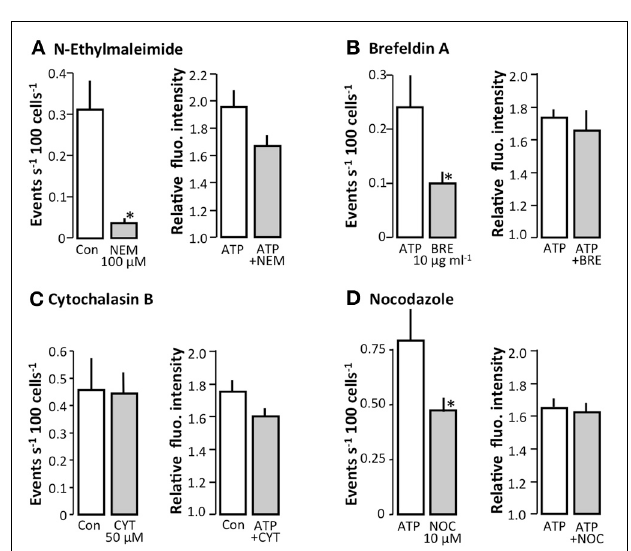
FIGURE 3 | The effect of various inhibitors of the exocytotic pathway on spontaneous [Ca 2 + ] i events in MDCK cells. (A) The effect of N-ethylmalimide (NEM, 100 μ M, n = 6), (B) Brefeldin A (BRE, 10 μ g ml − 1 , n = 13), (C) Cytochalasin B (CYT, 50 μ M, n = 5), and (D) Nocodazole (NOC, 10 μ M, n = 7). The left hand side of the figures show the spontaneous [Ca 2 + ] i events and the right hand side shows the response to the application of ATP (100 μ M). All values are mean ± s.e.m. The asterisks indicate statistical significance.